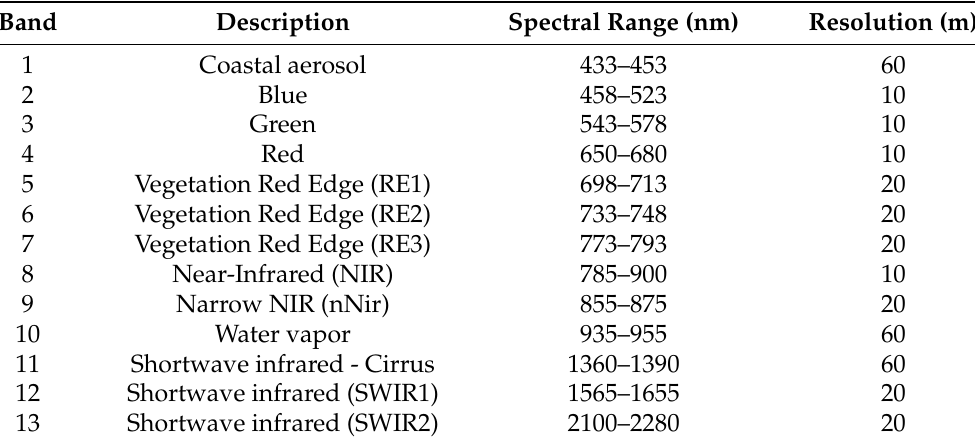
Table 2. Spectral bands of Sentinel-2 MSI. The S2 bands with 10 m or 20 m spatial resolution were used in this study.